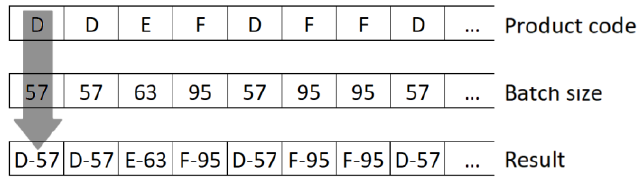
Figure 1. Decoding.